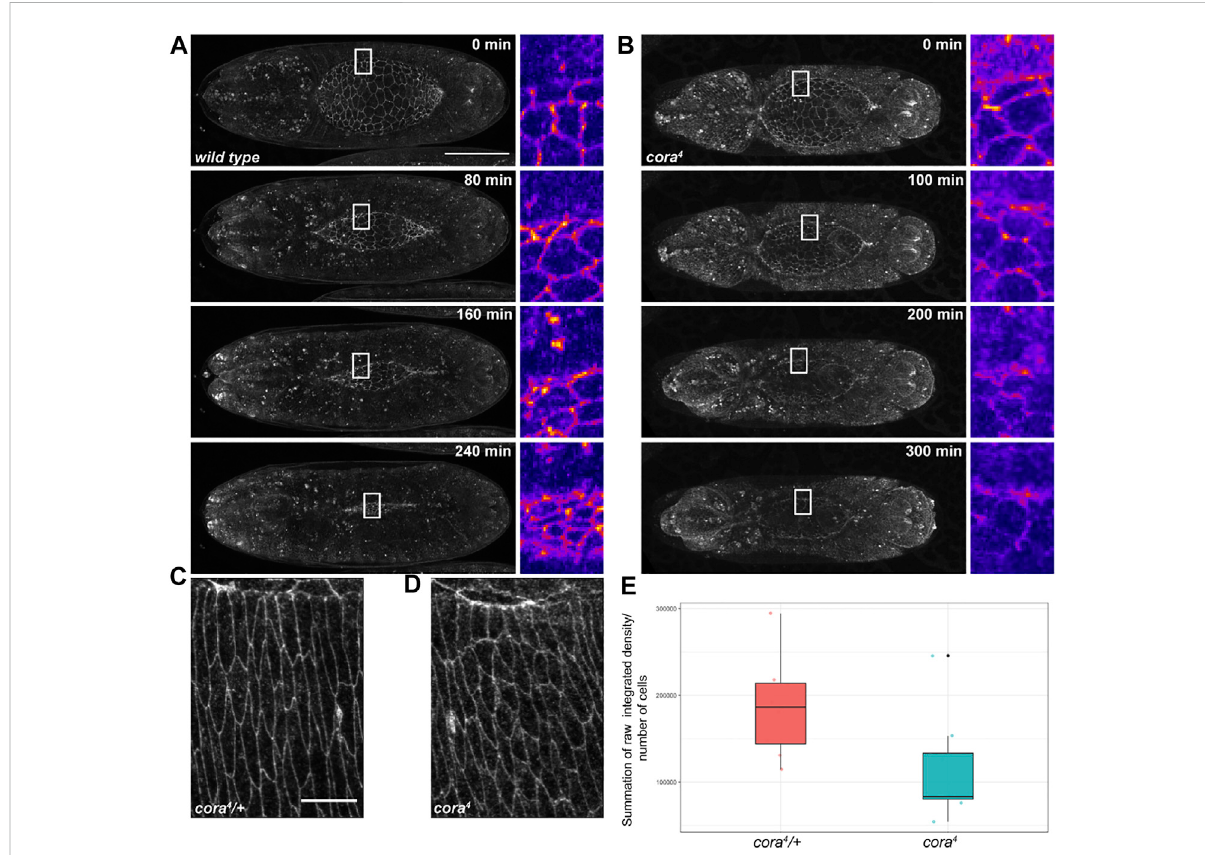
FIGURE 7 E-cadherin is depleted in SJ mutant embryos. (A,B) Still images from confocal time series during dorsal closure of wild type and cora 4 mutant embryos expressing tdTomato-tagged E-cadherin. E-cadherin fl uorescence marking the edge of the dorsal hole and amnioserosa cell junctions is maintained and even brightened over the course of closure in wild type embryos but fades in the region around the dorsal hole in septate junction mutants. Whiterectangles indicate regions shown in zoomed out images, whichare shownusing Fiji ’ s “ Fire ” lookup table. (C,D) Z-projection of summed slices from zoomed in regions of z-series of stage 14 cora 4 /+ and cora 4 embryos stained with an antibody against E-cadherin. Note: the z-projectionof cora 4 embryoshasmorecellsthanthecontrol. (E) Boxplotshowingthedistributionofnormalizedtotalpixelintensityvaluesforstage 14 cora 4 /+ (inred)and cora 4 embryos(incyan).Themeannormalizedrawintegrateddensityfor cora 4 /+ was186440.8pixels/cell,whereasthemean value for cora 4 animals was113008.1 pixels/cell, which was statistically different from cora 4 /+ embryos ( p < 0.05; bootstrap approach). All values